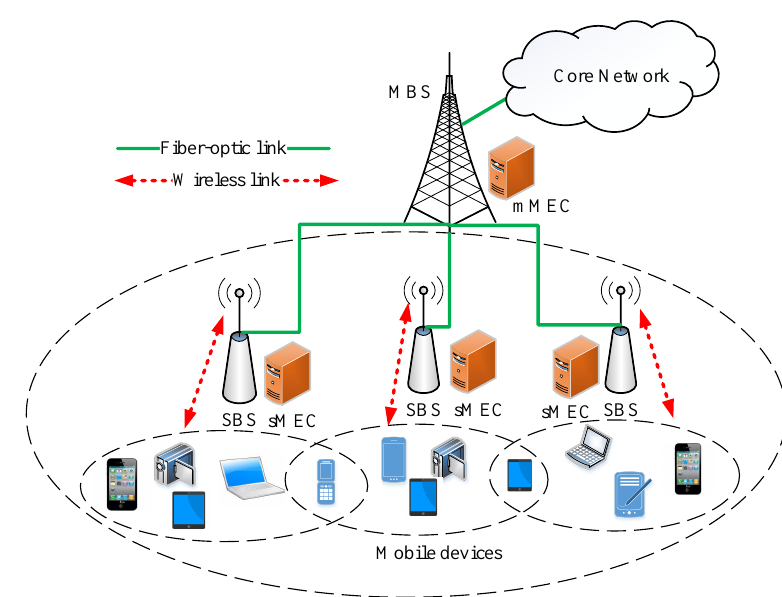
Figure 1. Multi-tier computation-offloading strategy in